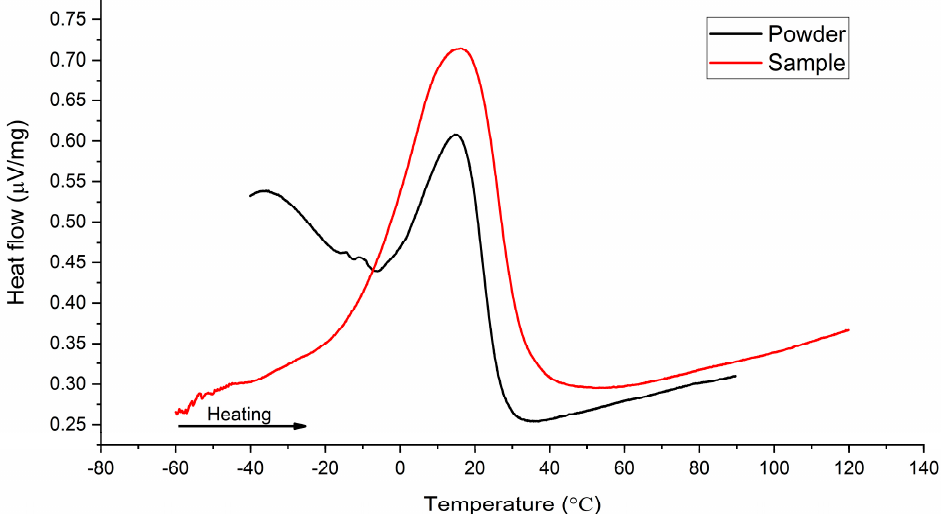
Figure 8. DSC curves for initial powder and lattice structure sample fabricated by the SLM tech ‐